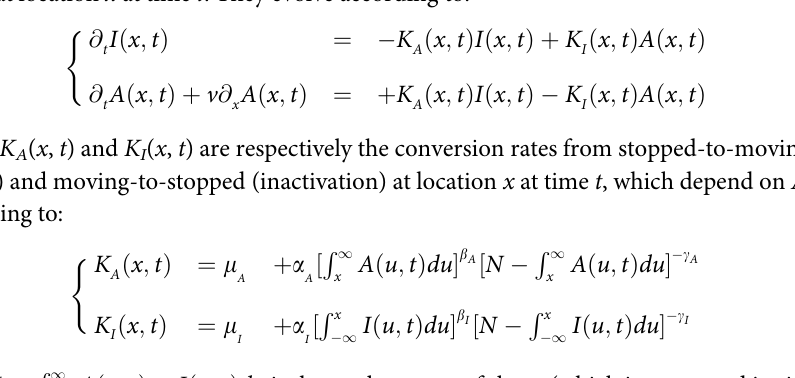
Fig 4. Predicted packing as a function of the intensity of the stimulating effect. To examine the transition from mostly diffusive regime to mostly advective regime, we varied the stimulation parameters α factor spanning from 10 − 4 to 10 2 (keeping the spontaneous parameters μ A and μ I constant). For each value, we collected the average dispersal of the groups from 1000 Monte Carlo simulations with N = 4 individuals at time t = 1000 s. The dispersion was estimated from the range of the positions divided by N − 1, giving the average distance between two neighbours (meters/sheep). To the left of abcissa ( μ / α ! 1 ), spontaneous switching dominates over imitation while to the right ( μ / α ! 0), imitation is dominant. Group dispersion shows a smooth transition (over the log scale of the modulation factor) from the left where diffusion is completely dominant and saturating to the right where the packing of the group tends to 0. We note that in the latter limit, crowding effects should be taken into account. The biological values (modulation factor = 1) appears to favor maximally the cohesion (about one sheep every